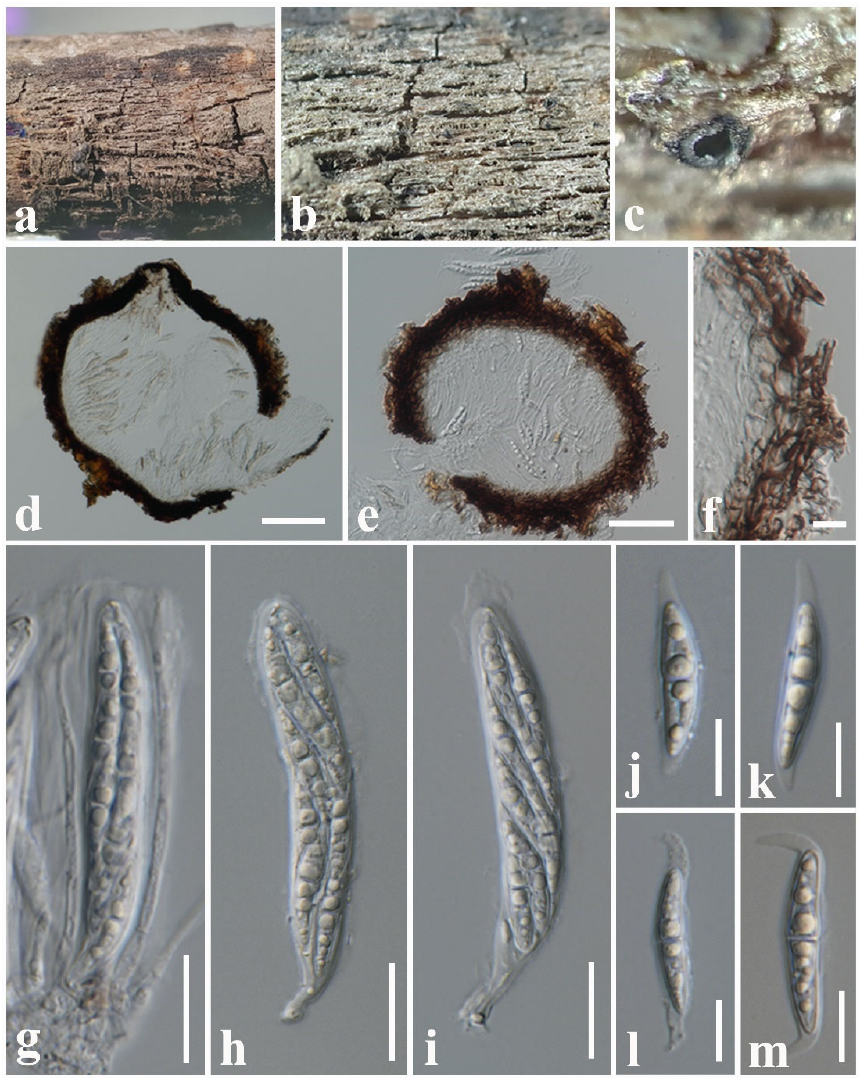
Figure 10. Ramusculicola thailandica (HKAS 107136, new host record). ( a ) The specimen. ( b , c ) Appearance of ascomata on substrate. ( d , e ) Vertical sections through ascoma. ( f ) Peridium. ( g ) Ascus and pseudoparaphyses. ( h , i ) Asci. ( j – m ) Ascospores. Scale bars: ( d , e ) = 50 μ m, ( f ) = 10 μ m, ( g – i ) = 20 μ m, ( j – m ) = 10 μ m.